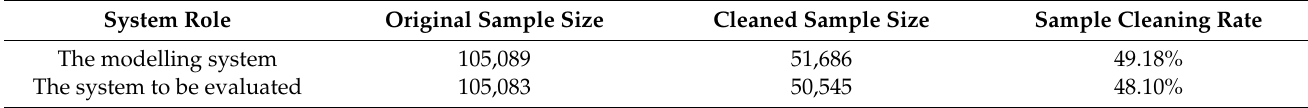
Table 3. Sample cleaning results.